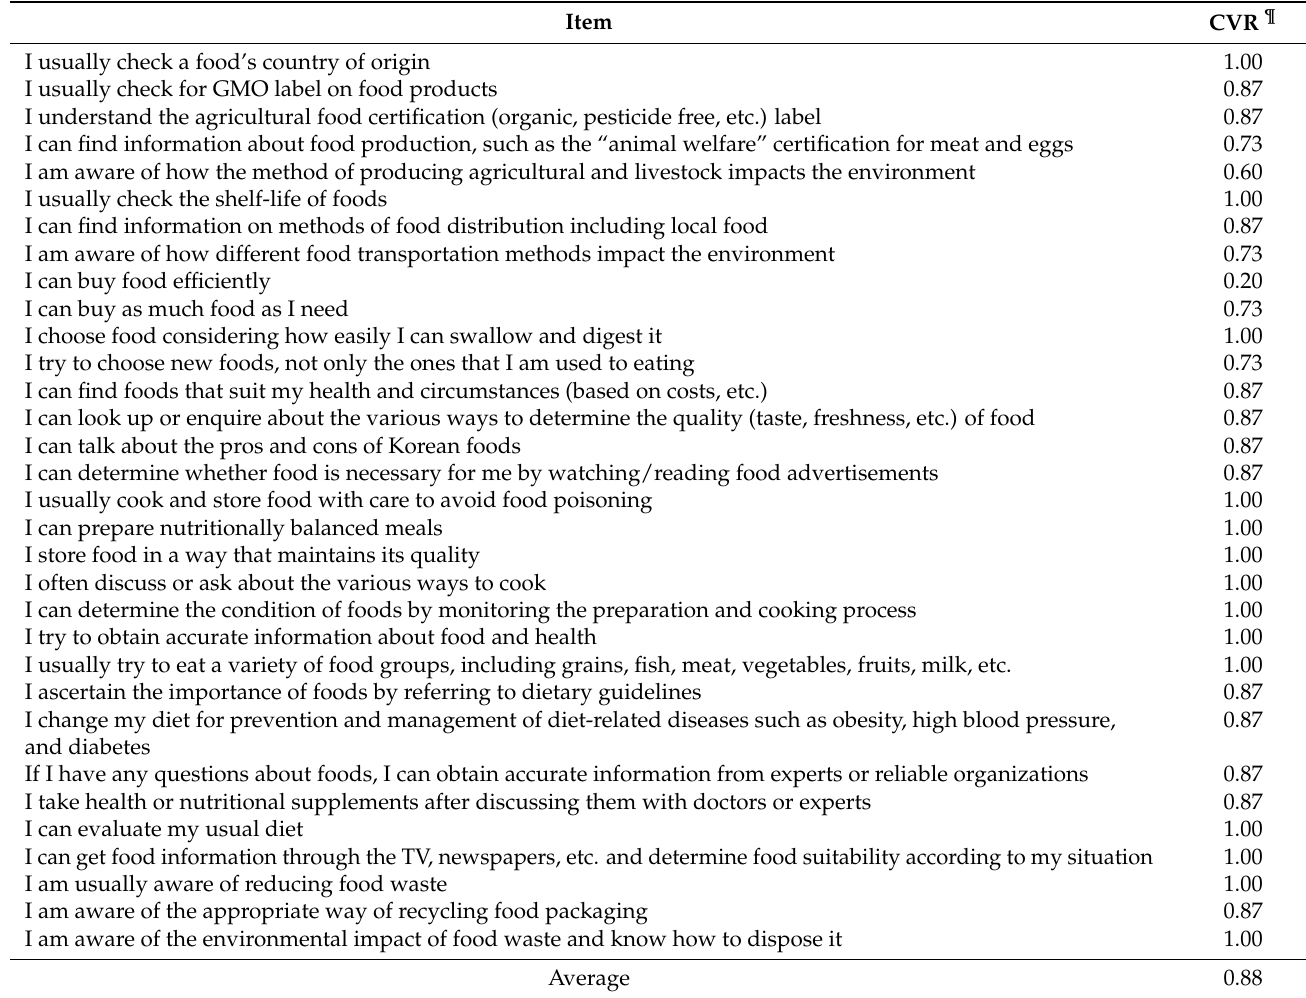
Table 1. Content validity ratio values of the final 32 questions. Item CVR